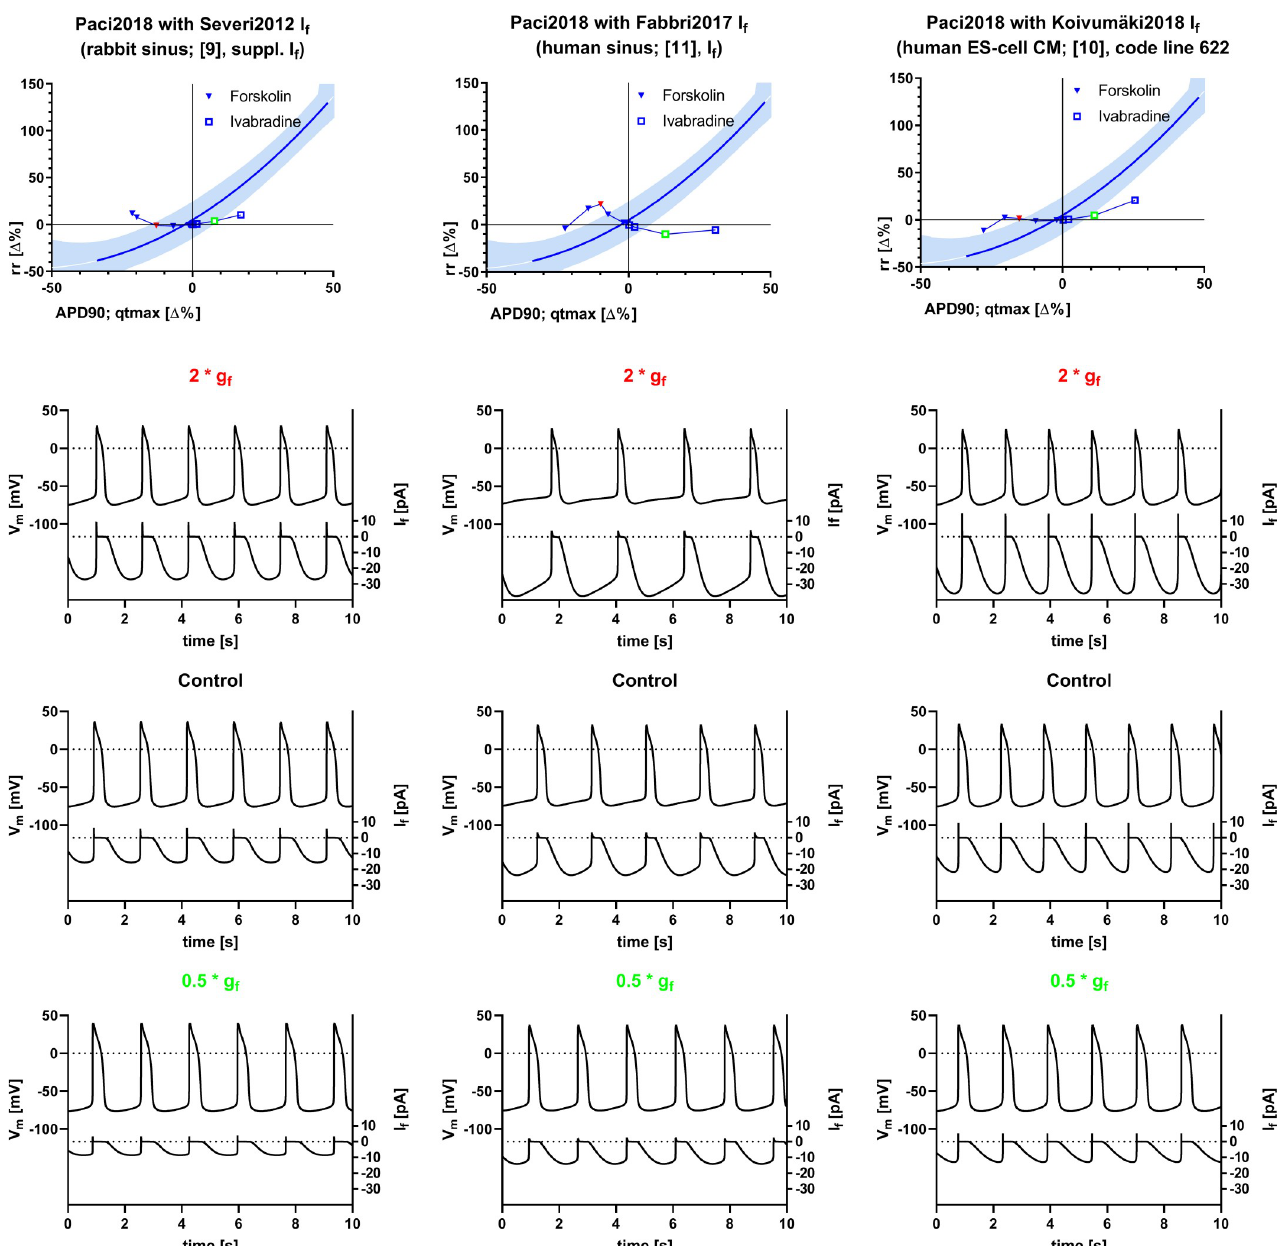
Fig 3. Inter-relation of rr and repolarization (APD90 for simulations, qtmax for experimental data) after modulation of g f in the Paci2018 [7] model with modified I f . I f , in the model from [7] was substituted with the equation for I f from [9] (Severi2012, left column), [11] (Fabbri2017, middle column), and [10] (Koivuma¨ki2018, right column). For an explanation of colors, symbols, and simulated traces see Fig 1. The graphical representation of experimental data is modified from [1] and for illustrative purposes